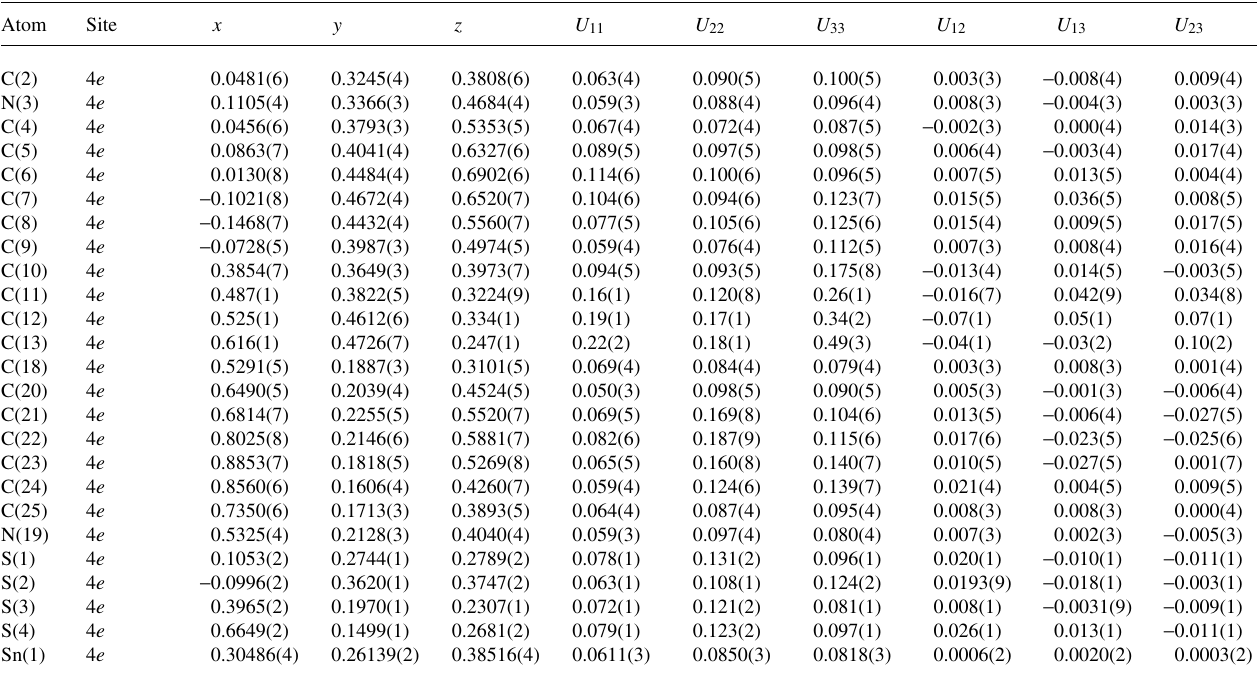
Table 3. Atomic coordinates and displacement parameters (in Å 2 )